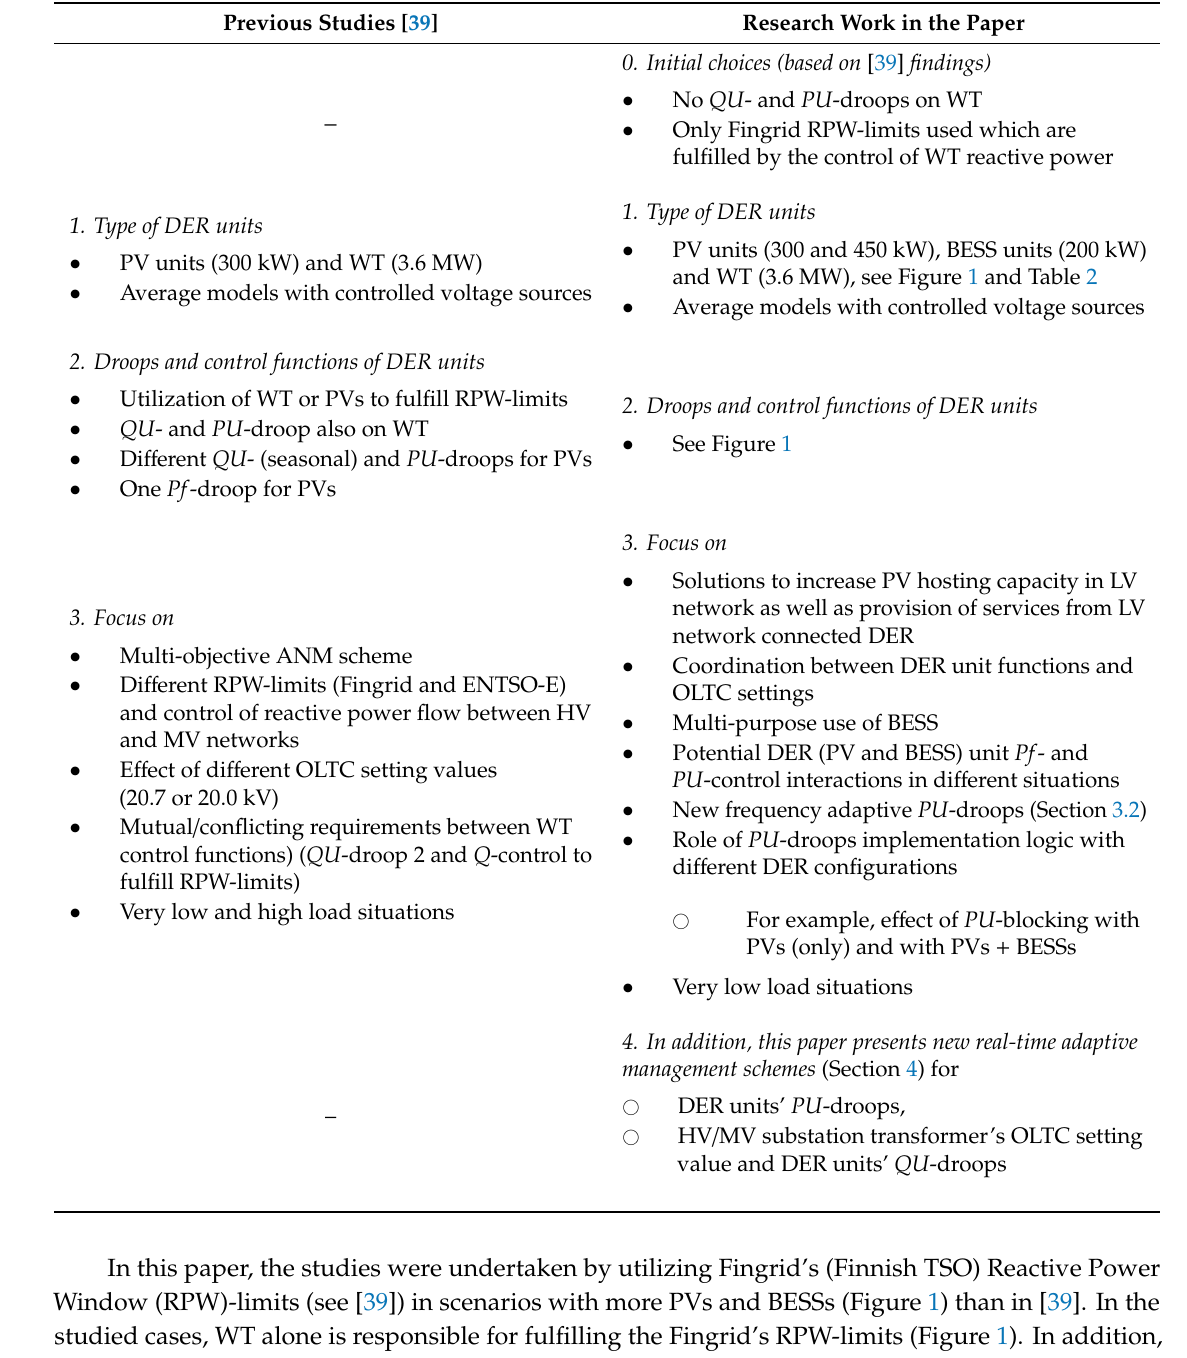
Table 1. Main focus areas of previous studies [39] and research work done in this